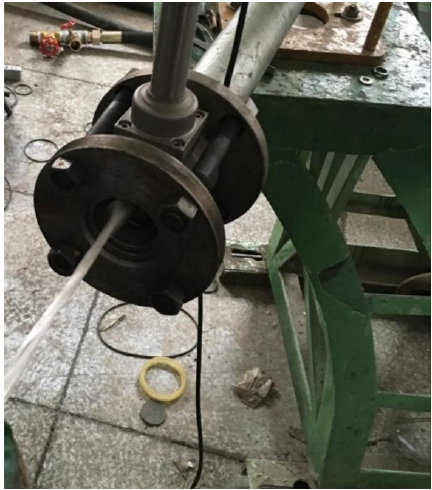
Figure 4. Suction performance of the reverse circulation apparatus.